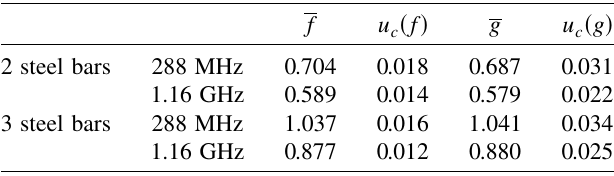
TABLE I. Left-hand side term ( f ) and right-hand side term ( g ) of the identity (49) with their